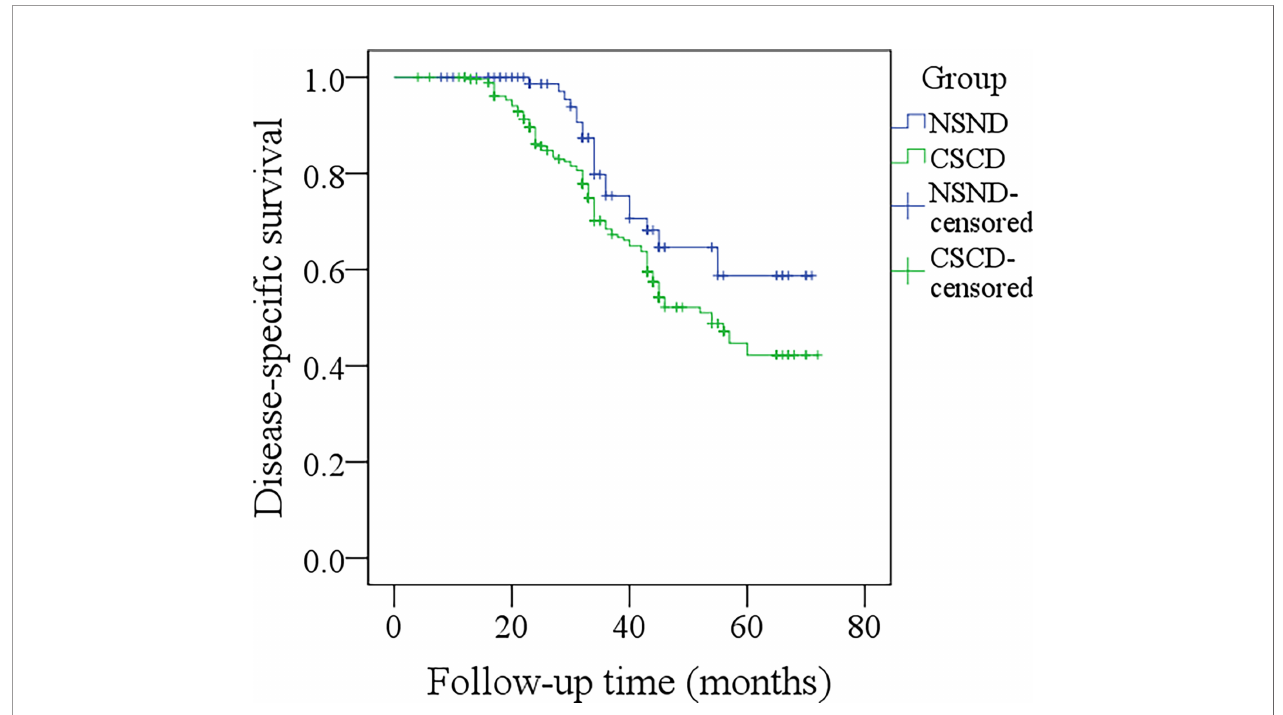
FIGURE 2 | Comparison of disease-speci fi c survival between the non-smoker and non-drinker group and the current-smoker or current-drinker (CSCD) group (p = 0.047).